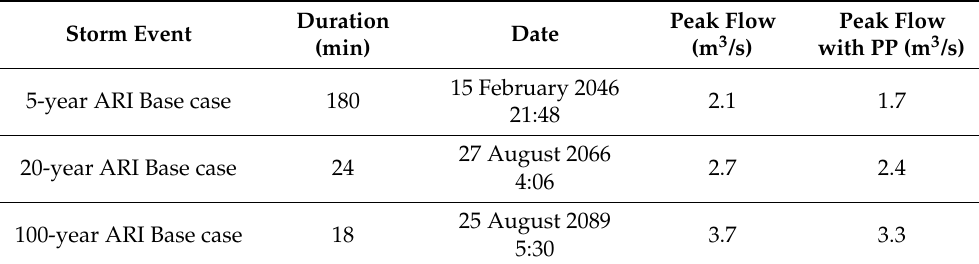
Figure 5. Discharges for different ARI storm events with and without permeable pavements. Critical flooding rate is shown by the black continuous line in the figure. Table 2. Peak flow and corresponding rainfall duration for each storm event considered.